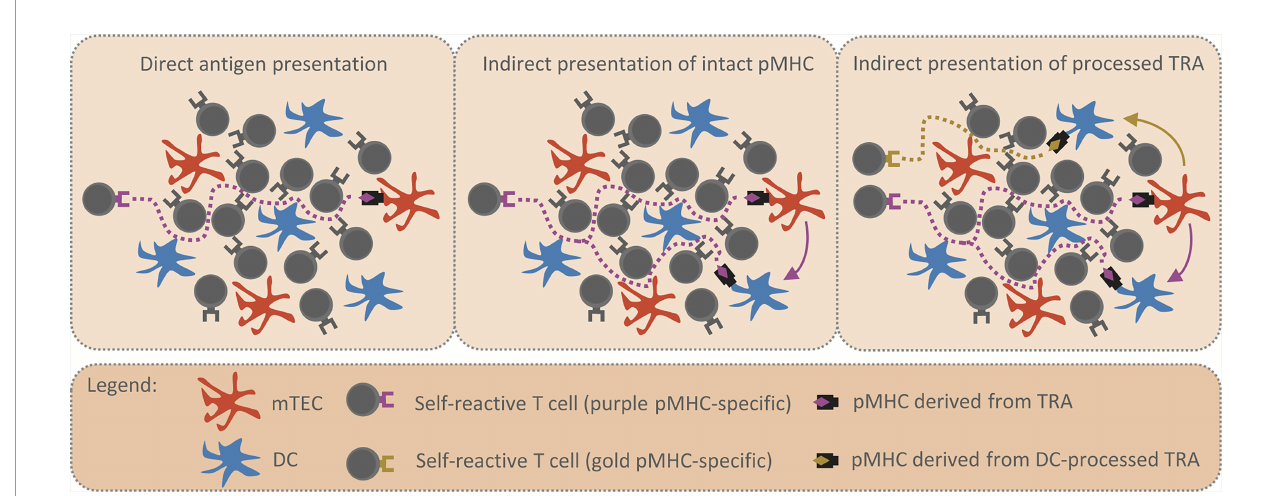
FIGURE 1 | Reinforcement of central tolerance by indirect presentation. The schemes depict model situations in which self-reactive T cells (purple and golden TCR) migrate through the thymic medulla to engage their cognate TRA (purple and golden rhombus) presented by mTEC (in orange) or DC (in blue) and undergo the processes of central tolerance. Possible migration pathways of self-reactive T cells are visualized by the dotted lines. The fi rst scheme (left panel) displays the situation where TRA is presented directly by a single mTEC, thus, there is a low probability that a self-reactive T cell will encounter the mTEC and be tolerized. In the second scheme (middle panel), the intact pMHC shown in the left scheme is transferred from mTEC to DC (purple arrow). The antigen presentation is enhanced, since the same TRA is presented both directly and indirectly by mTEC and DC, respectively. The third scheme (right panel) captures the situation in which the TRA is transferred to (golden arrow) and subsequently processed by DC. Since the antigen processing machinery of DC is distinct from that of mTEC, a DC-processed pMHC complex (golden rhombus) is recognized by a self-reactive T cell of different speci fi city (golden TCR) from the original (purple TCR). Therefore, indirect presentation not only enhances antigen presentation in the medulla (middle panel), it also broadens the repertoire of T cell clones subjected to processes of central tolerance (right